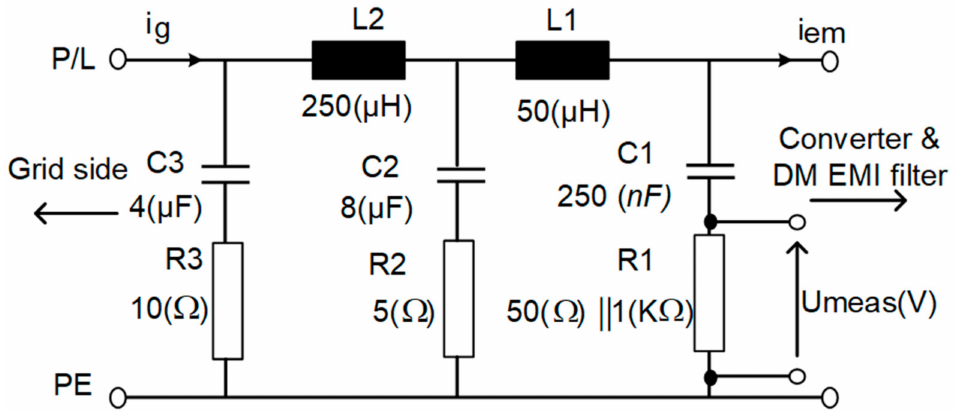
Figure 3. LISN per-phase circuit diagram recommendation by CISPR-16 for 9–500 kHz